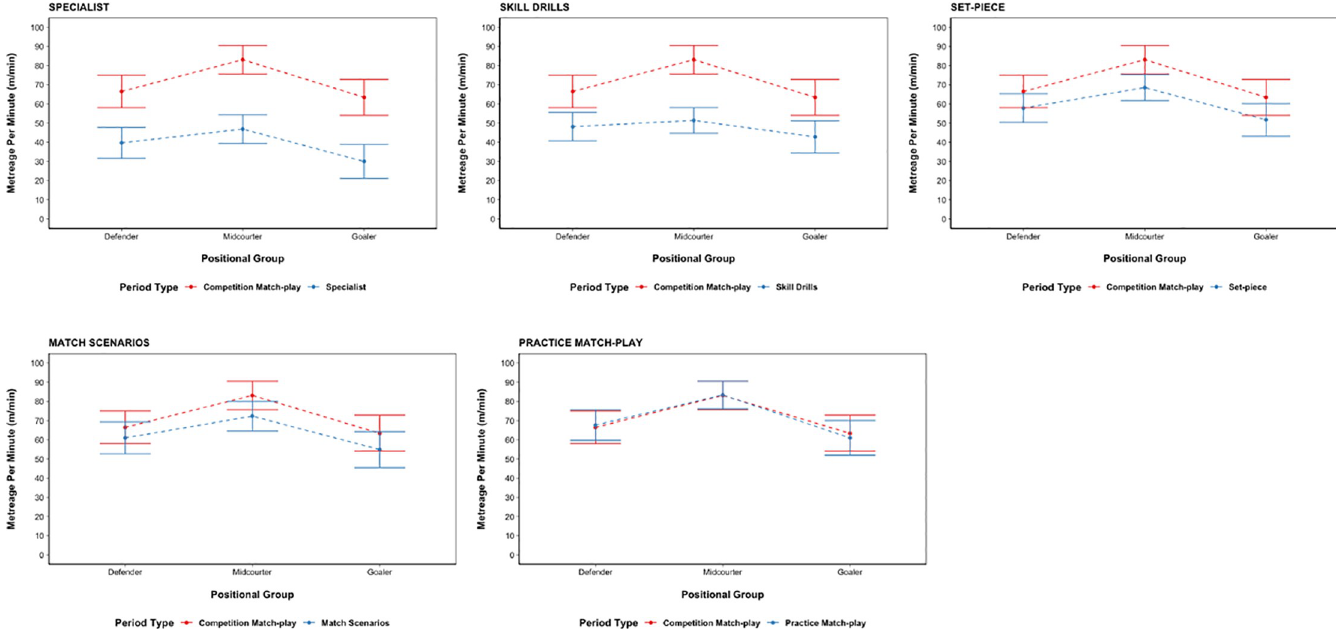
Fig 2. Comparison of Metreage per minute for each activity type against competition Match-play. The model estimated marginal means and 95% confidence intervals are presented for each of the comparisons. Abbreviations; au/min = arbitrary units per minute.